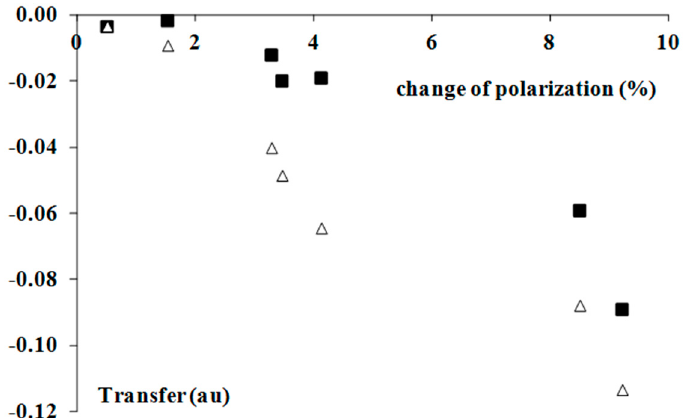
Figure 4. The dependencies between the percentage change of the mean polarization of the Br-F equatorial bond as an effect of complexation and the electron charge transfer from the Lewis base to the Lewis acid unit (in au); white triangles correspond to the Hirshfeld charges, while black squares to the NBO population.